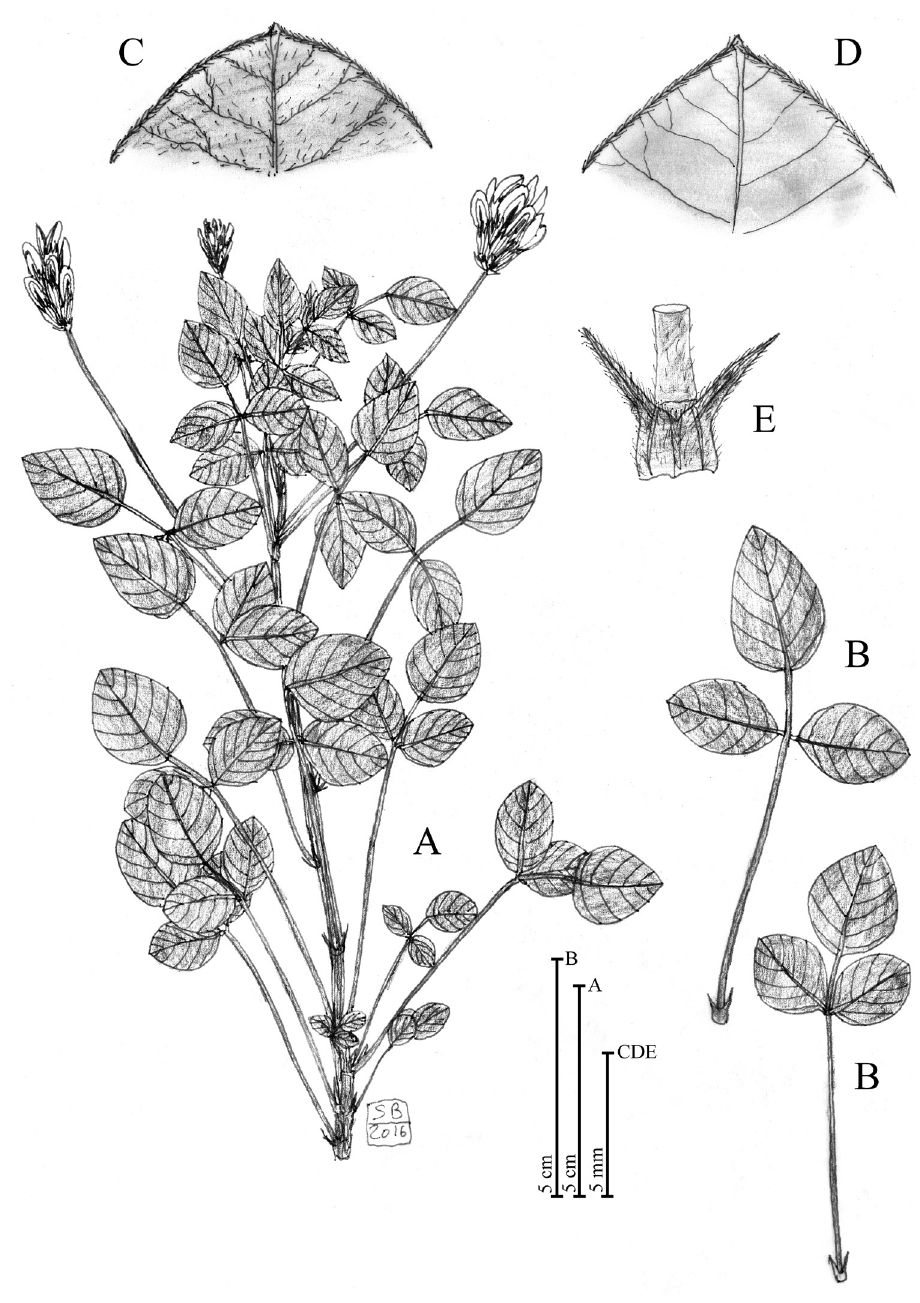
Figure 2. Diagnostic features regarding the vegetative structures of Bituminaria antiatlantica . A Habit B Leaves C Leaf apex (abaxial side) D Leaf apex (adaxial side) E Stipules. Illustration by S. Brullo based on living material coming from Mount Tachilla and Djebel Imzi in Morocco